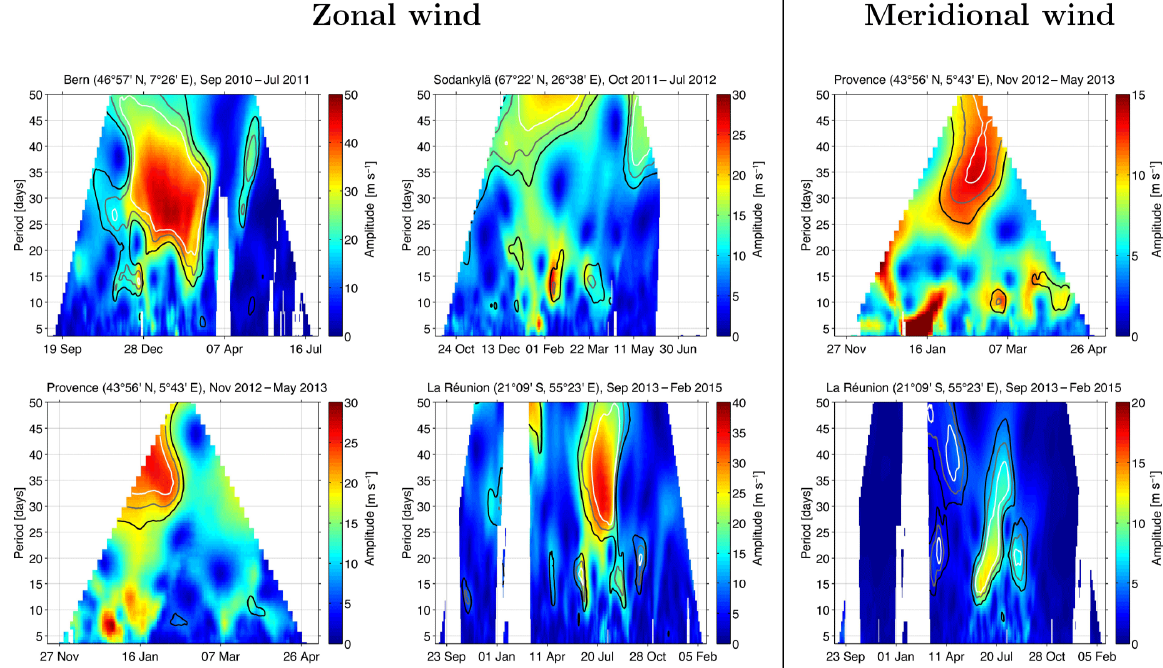
Figure 5. Temporal evolution of the periodogram at stratopause level (0.9hPa) for wind measurements taken by WIRA. The black, gray and white contour lines mark α = 0 . 5, 0.1 and 0.01 according to Eq. (6). The lowest value, i.e., the white contour, corresponds to highest signif- icance. White areas represent times for which B j contains indices before the start date or after the end date of the respective measurement campaign (which entails the trapezoidal shape of the colored area). Other areas are blanked out because the conditions of Eq. (4) are not satisfied, i.e., WIRA cannot provide reliable information due to an insufficient number of data points. Please note the occurrence of 16-day oscillations near the onset and the termination of the extra-long period oscillation in zonal wind for Bern and La